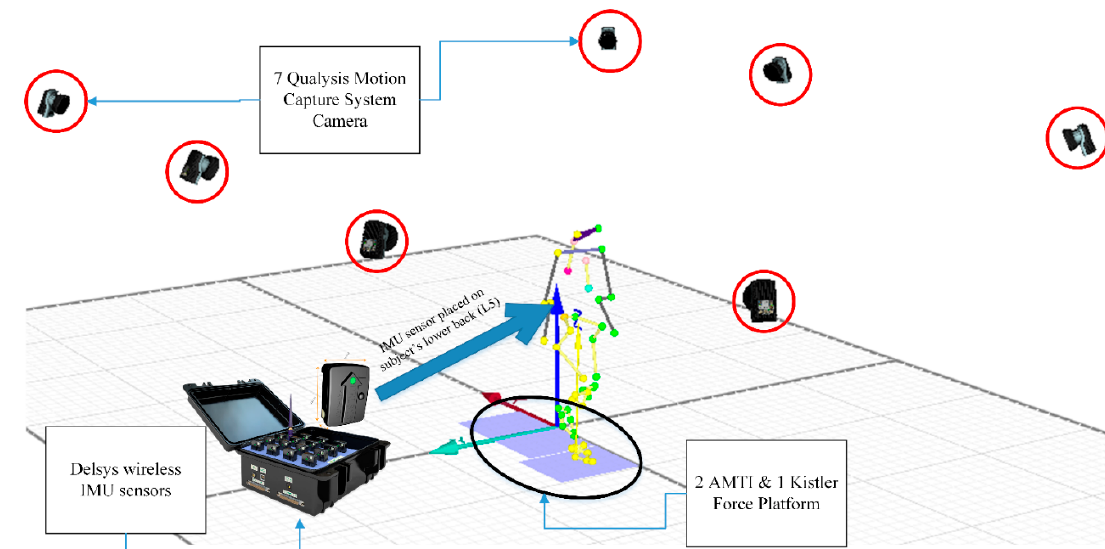
Figure 1. Illustration of synchronized sensor and equipment (motion-capture system). IMU, inertial measurement unit; AMTI, Advanced Mechanical Technology, Inc. (Watertown, MA,